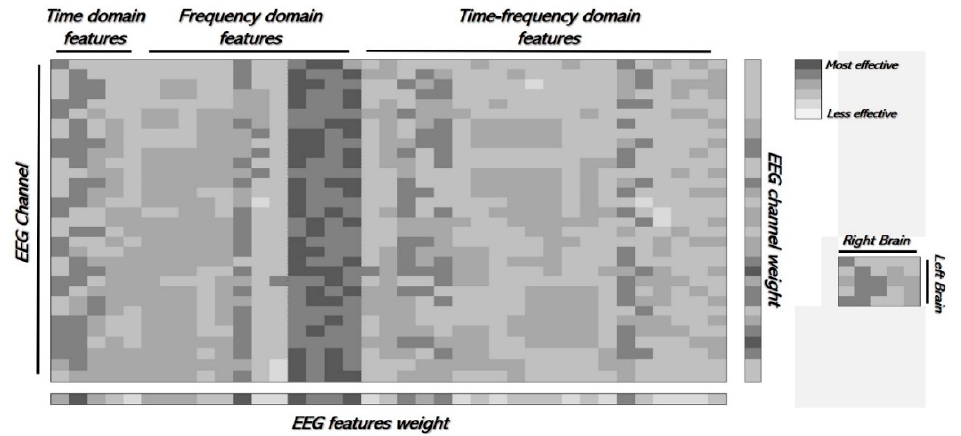
Figure 10. EEG feature weights, channel weights of GA-LSTM in the MANHOB-HCI dataset.